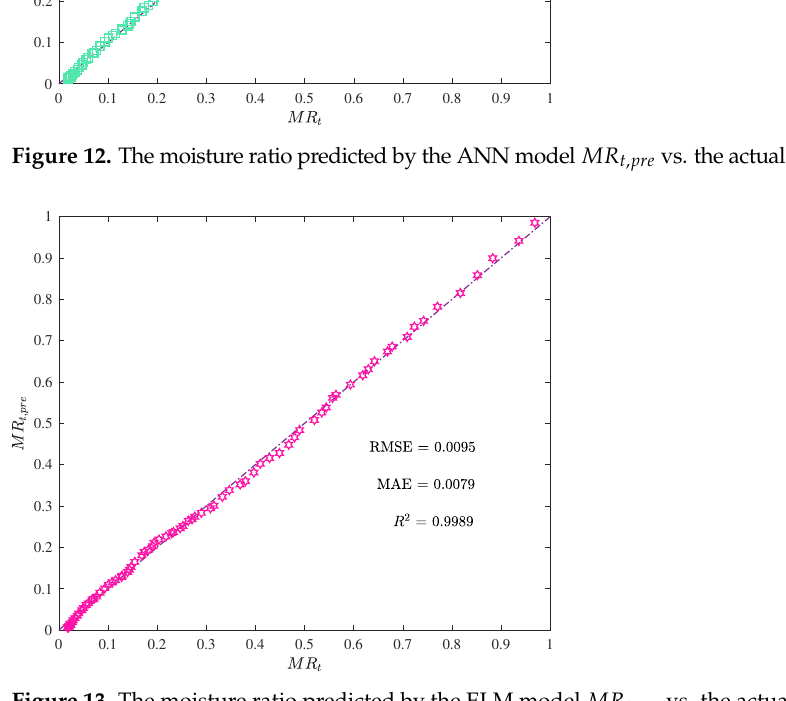
Figure 13. The moisture ratio predicted by the ELM model MR t , pre vs. the actual moisture ratio MR t